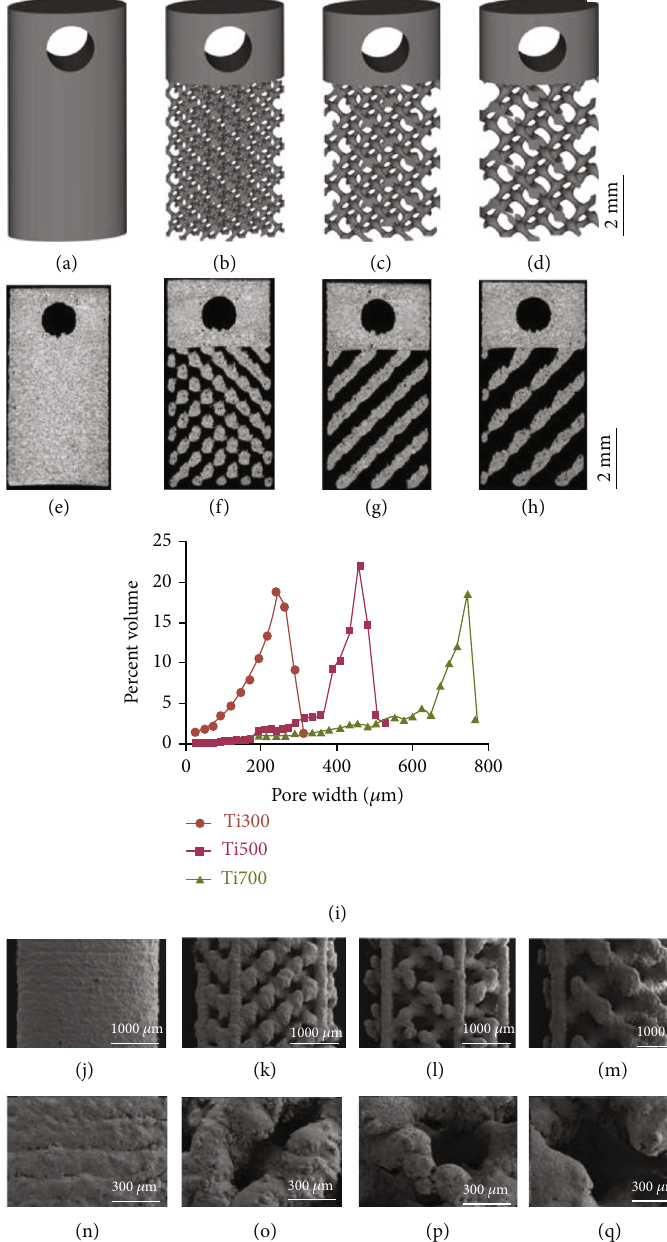
Figure 1: Design and characterization of the titanium implants. (a) – (d) Design of the titanium implants. (a) indicates solid, (b) indicates Ti300, (c) indicates Ti500, and (d) indicates Ti700. (e) – (h) 2D reconstructed image of the titanium implants. (e) indicates solid, (f) indicates Ti300, (g) indicates Ti500, and (h) indicates Ti700. (i) Pore volume distributions in groups Ti300, Ti500, and Ti700. (h) – (q) SEM image of the titanium implants at × 60 (j) – (m) and × 200 (n) – (q). (j) and (n) indicate solid, (k) and (o) indicate Ti300, (l) and (p) indicate Ti500, and (m) and (q) indicate